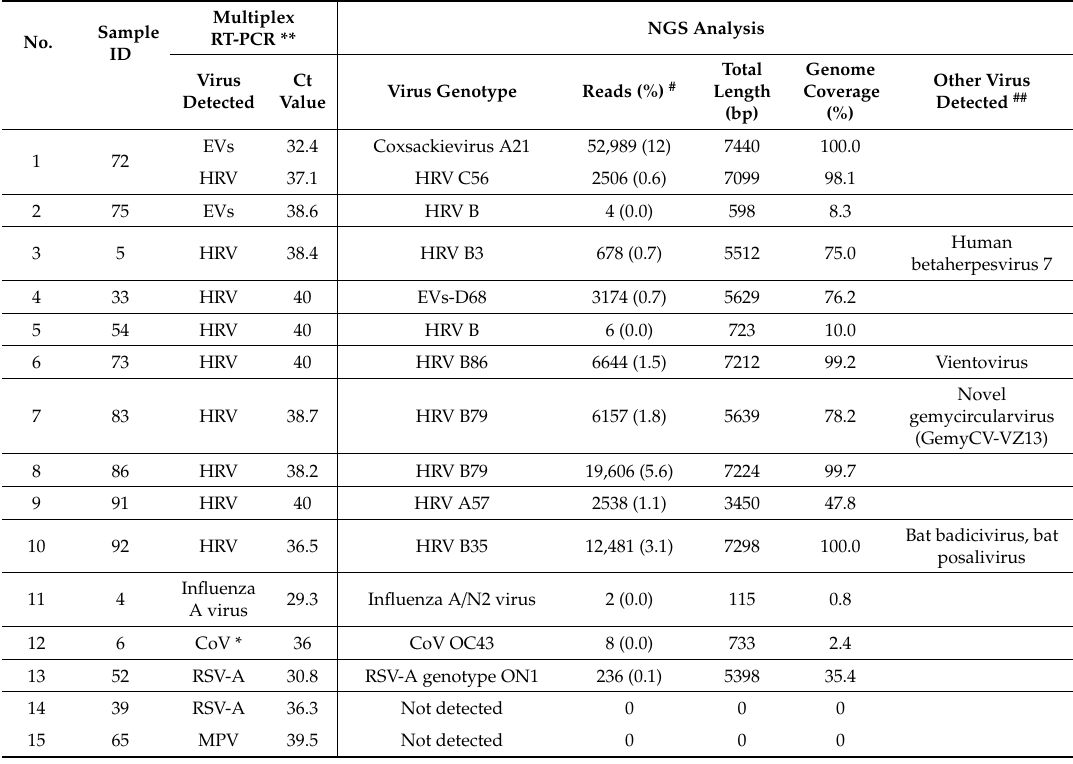
Table 2. Detection of respiratory viral pathogens of mNGS in 15 RT-PCR-positive samples where human viral pathogens were previously detected by diagnostic RT-PCR [5]. HRV: human rhinovirus, EVs: enterovirus, CoV: coronavirus subtype OC43 and NL63, RSV: respiratory syncytial virus, MPV: human metapneumovirus.